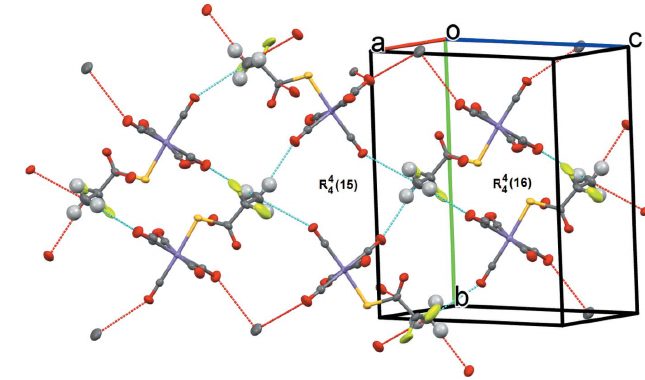
Figure 2 A view of the crystal packing of compound (1). The C—H (cid:2)(cid:2)(cid:2) O interactions (Table 2) involving the major component of the disordered –CF 2 group, are shown as dashed lines.